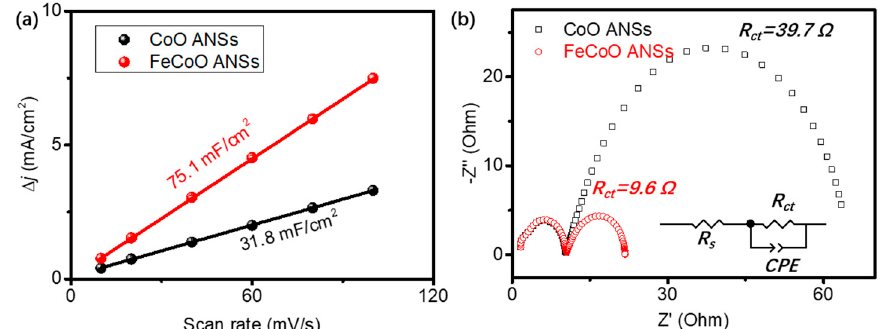
Figure 4. Analysis of catalysts and electrode. ECSA ( a ) and Nyquist plots ( b ) of ANS. The Fe doping can effectively promote the reactive sites with ca. 2-fold ( a ). The charge transfer efficiency between glassy carbon support and FeCoO x ANSs is very low ( b ). ECSA is calculated from double layered capacitance ( C dl ) at 1.15 V vs. RHE.